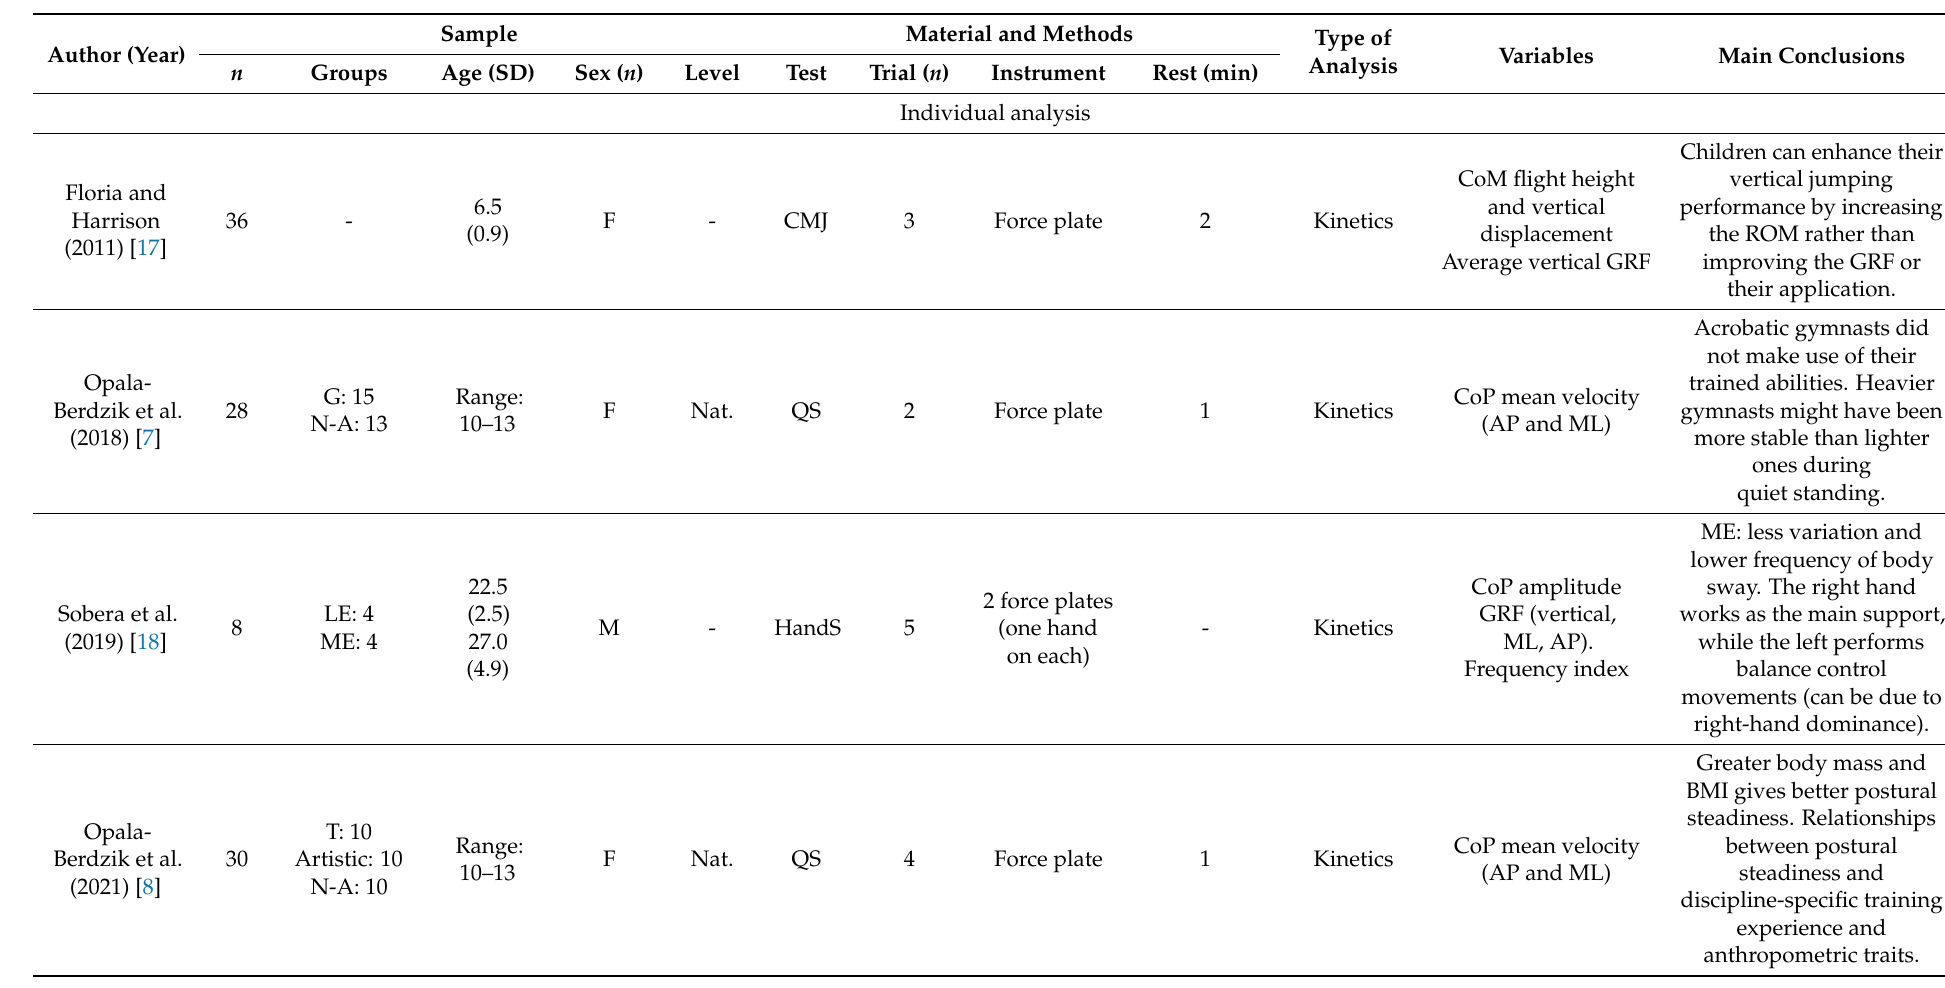
Table 2. General description of the sample, material and methods and main conclusions from the documents included in the review ( n =